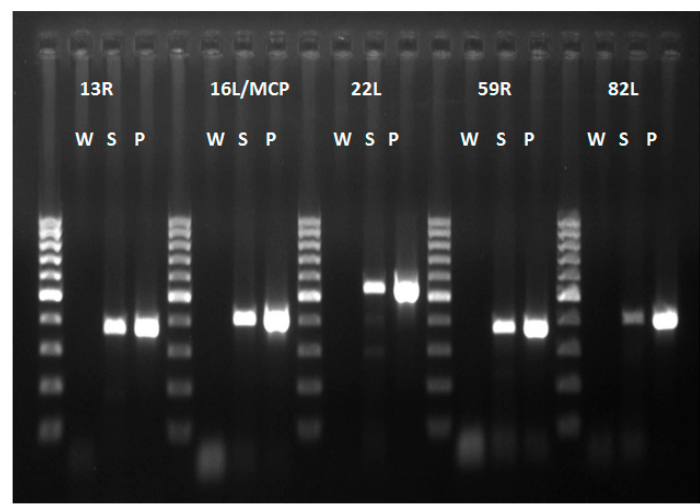
Figure 5. PCR products of five ranavirus genes. All products of the Mexican virus samples (S) are of similar size to those of the FV3 virus positive control (P). Abbreviations: W (water), S (Mexican virus sample), P (Positive control frog virus 3 isolate Oophaga pumilio /2015/Netherlands/UU3150324001 (GenBank no. MF360246)). 100 bp ladder. Viruses 2018 , 10 ,